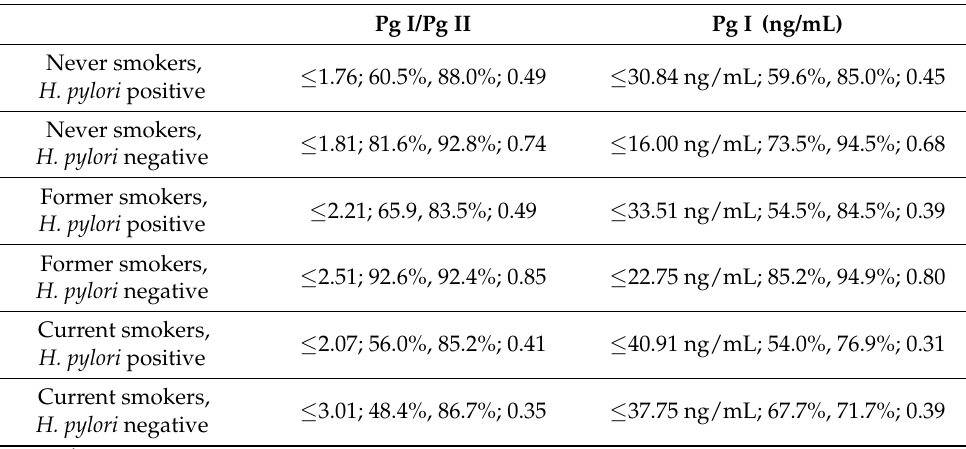
Table 5. Pepsinogen cut-off values adjusted for detecting precancerous gastric lesions in smokers by H. pylori presence.